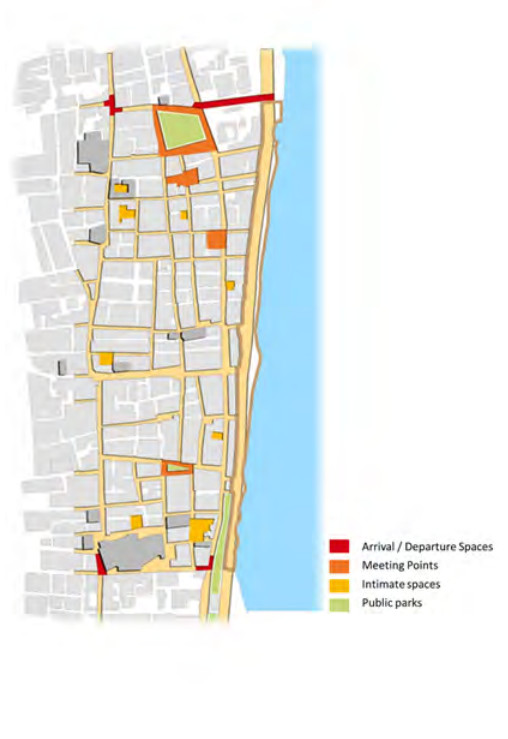
Figure 15. (Urban spaces Network)